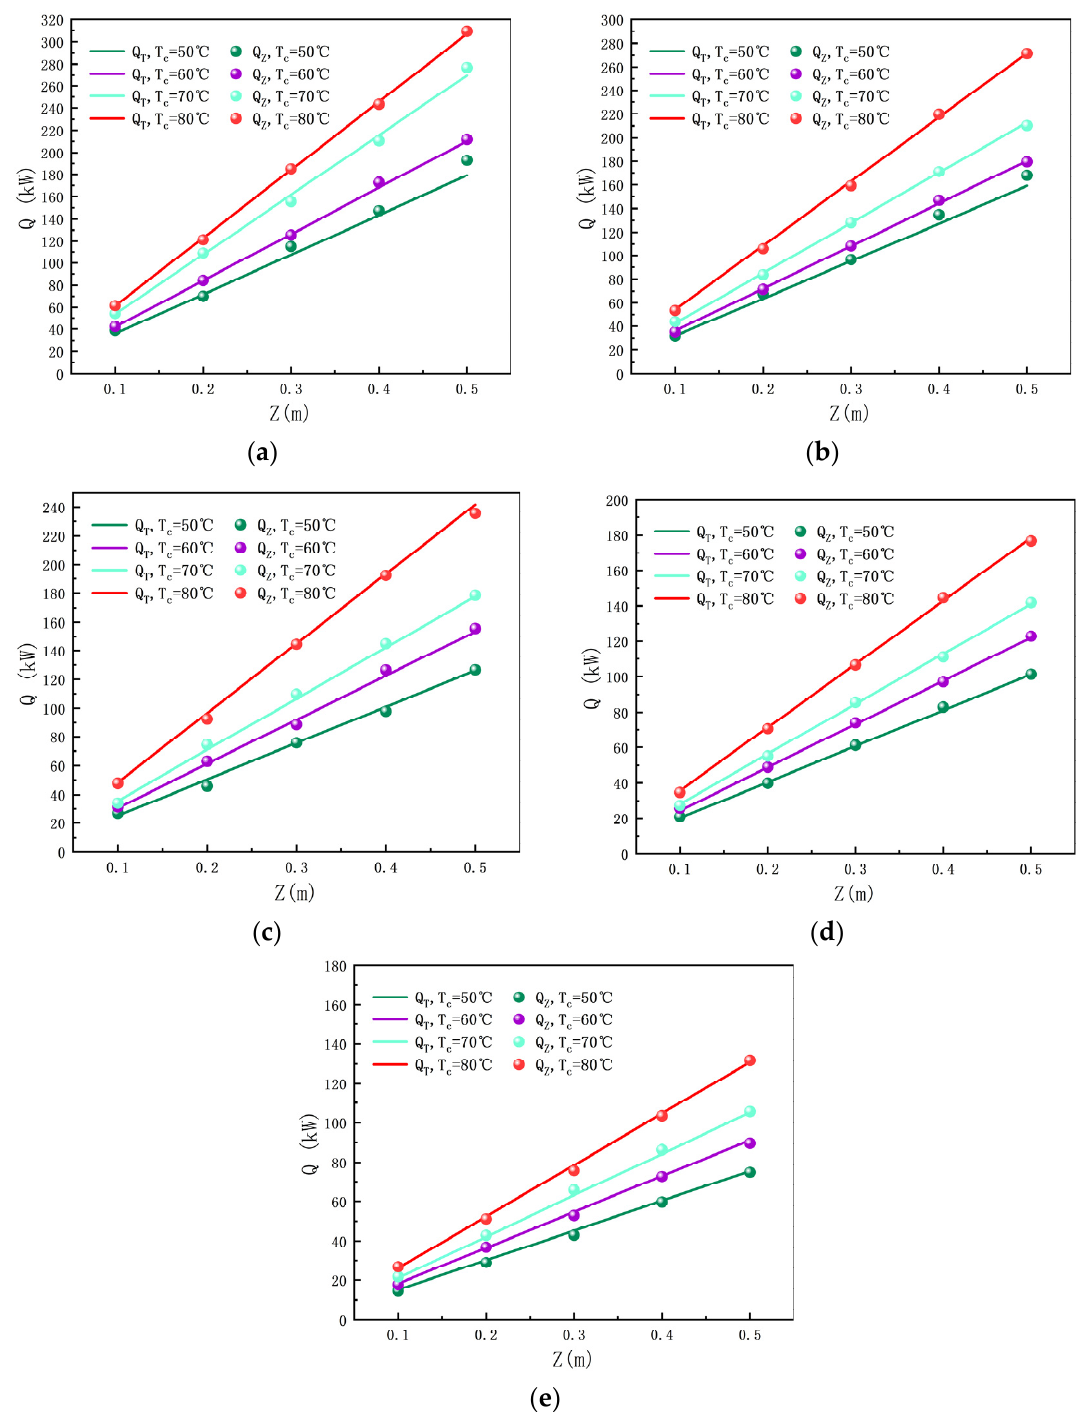
Figure 9. The relationship between heat transfer quantity and height (Z) under different flow rate ratios. ( a ): m d /m c = 1:5. ( b ): m d /m c = 1:4. ( c ): m d /m c = 1:3. ( d ): m d /m c = 1:2. e : m d /m c = 1:1.